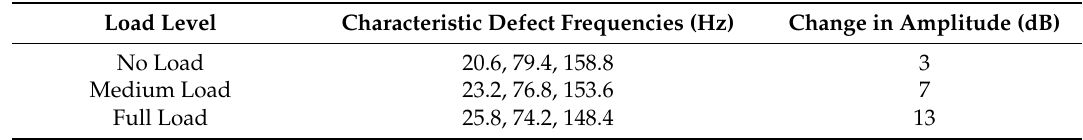
Table 3. Amplitude values for bearing outer race